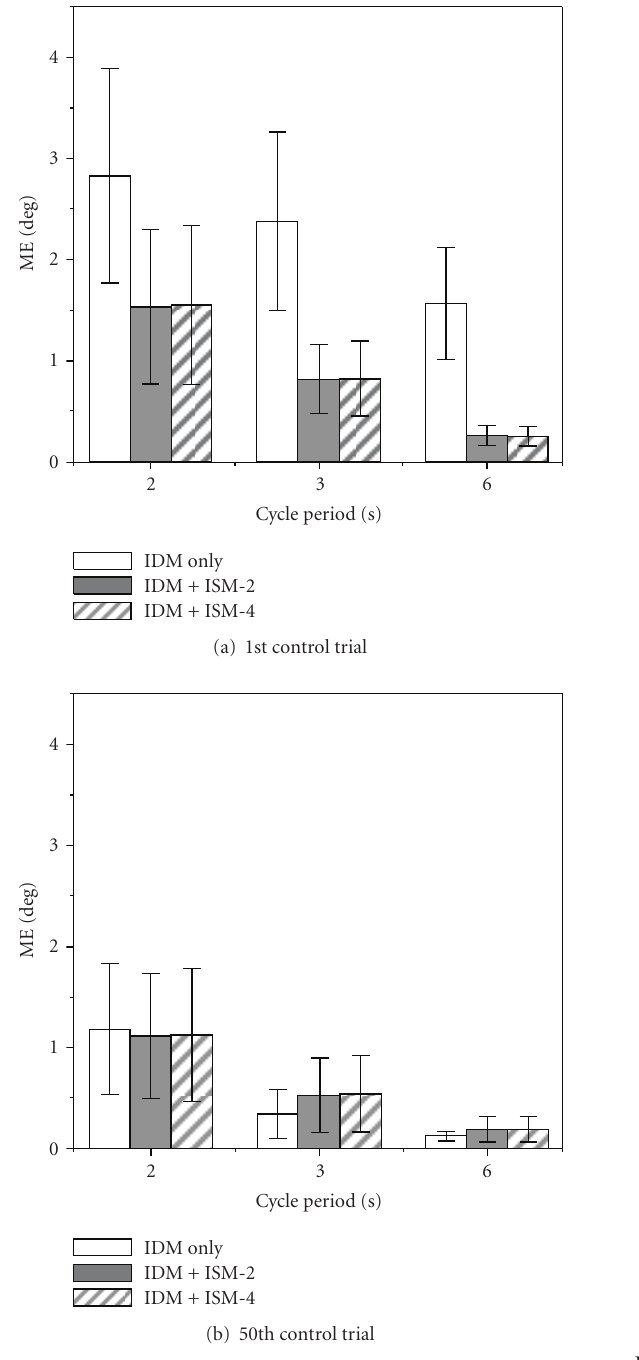
Figure 8: Average values of the mean error (ME) in tracking control by FEL-FES controllers. Error bar shows the standard deviation.